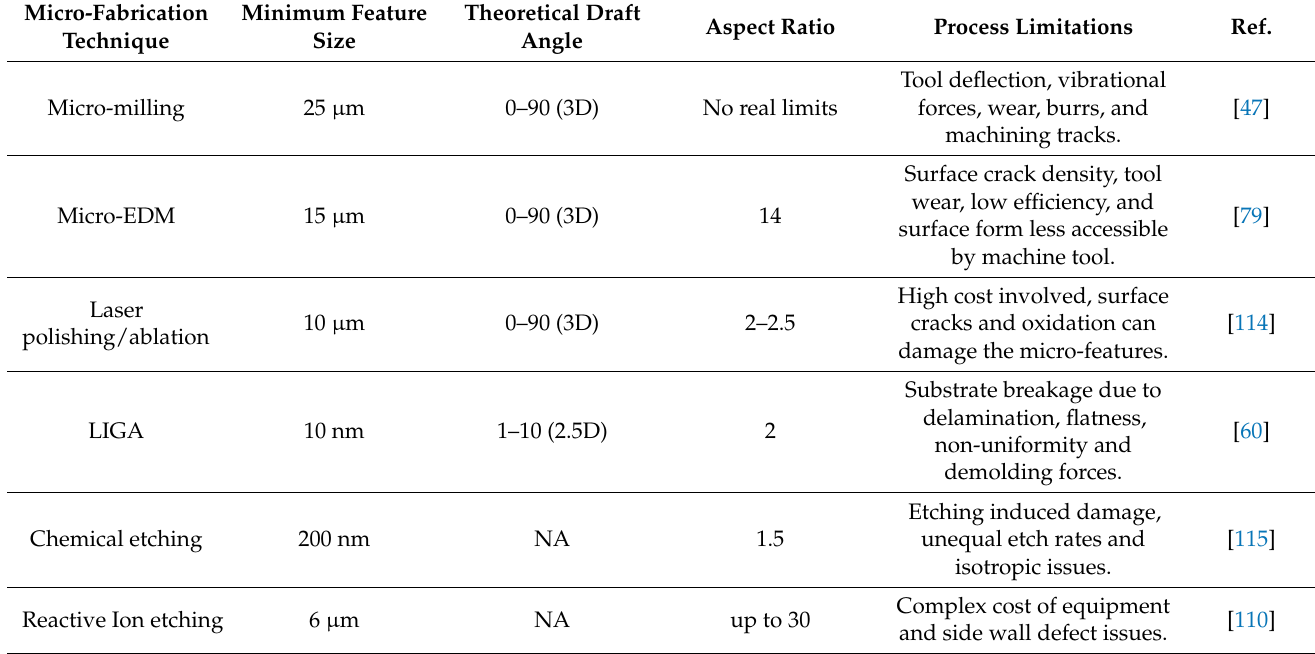
Table 1. Micro-feature sizes obtained from various manufacturing